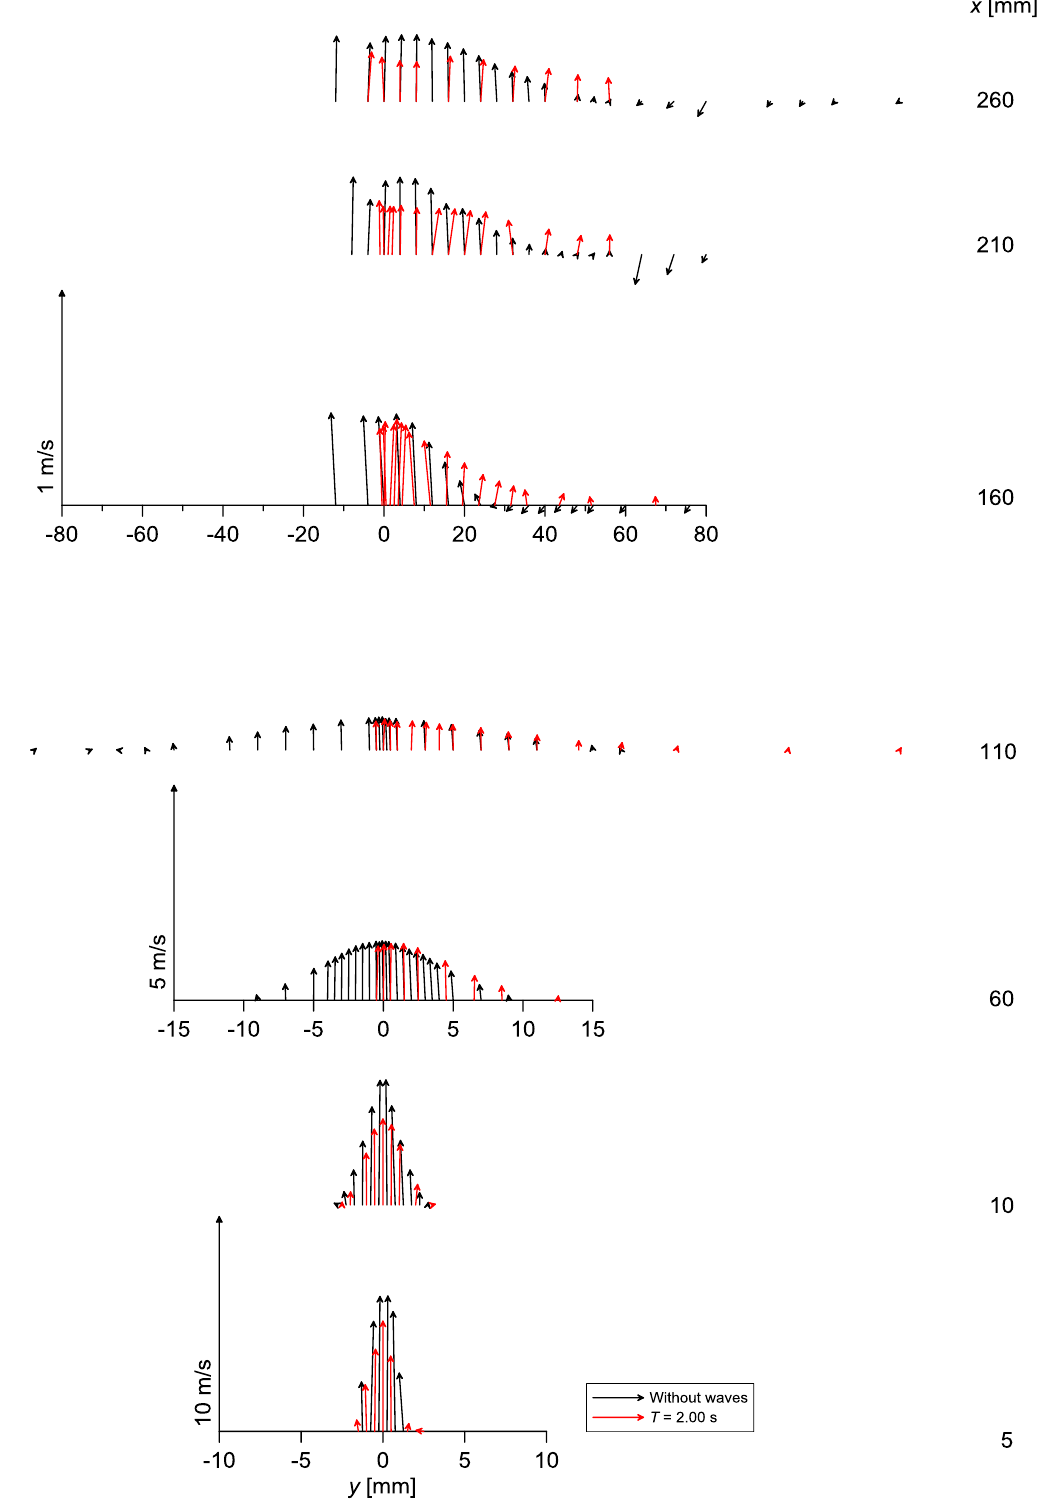
Figure 8. Time-averaged velocity vectors of Run 1 of Table 1 and of the same jet in still water. The comparison enables us to highlight the differences between the two configurations.